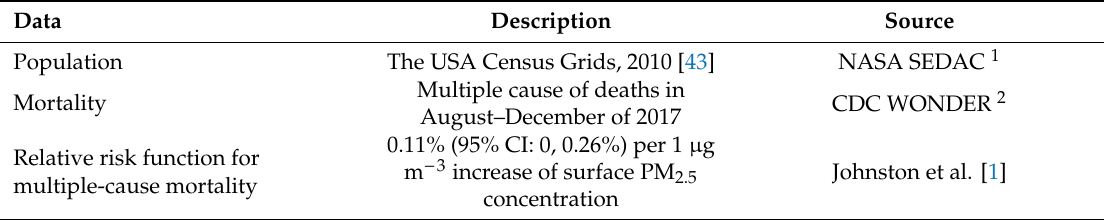
Table 3. The demographic data and relative risk function used for health impact